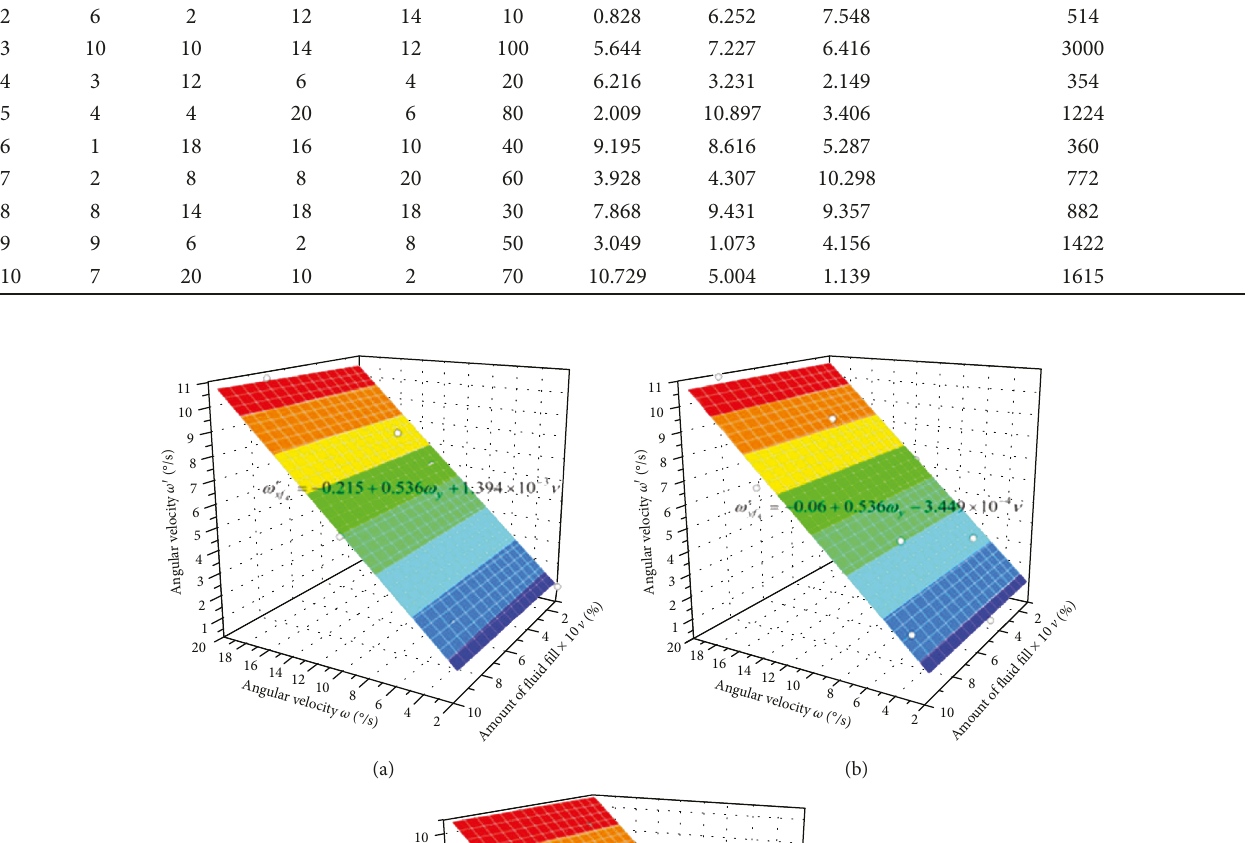
Figure 11: Fitting polynomial and surface fi tting results of liquid storage tank and microsatellite for (a) ω